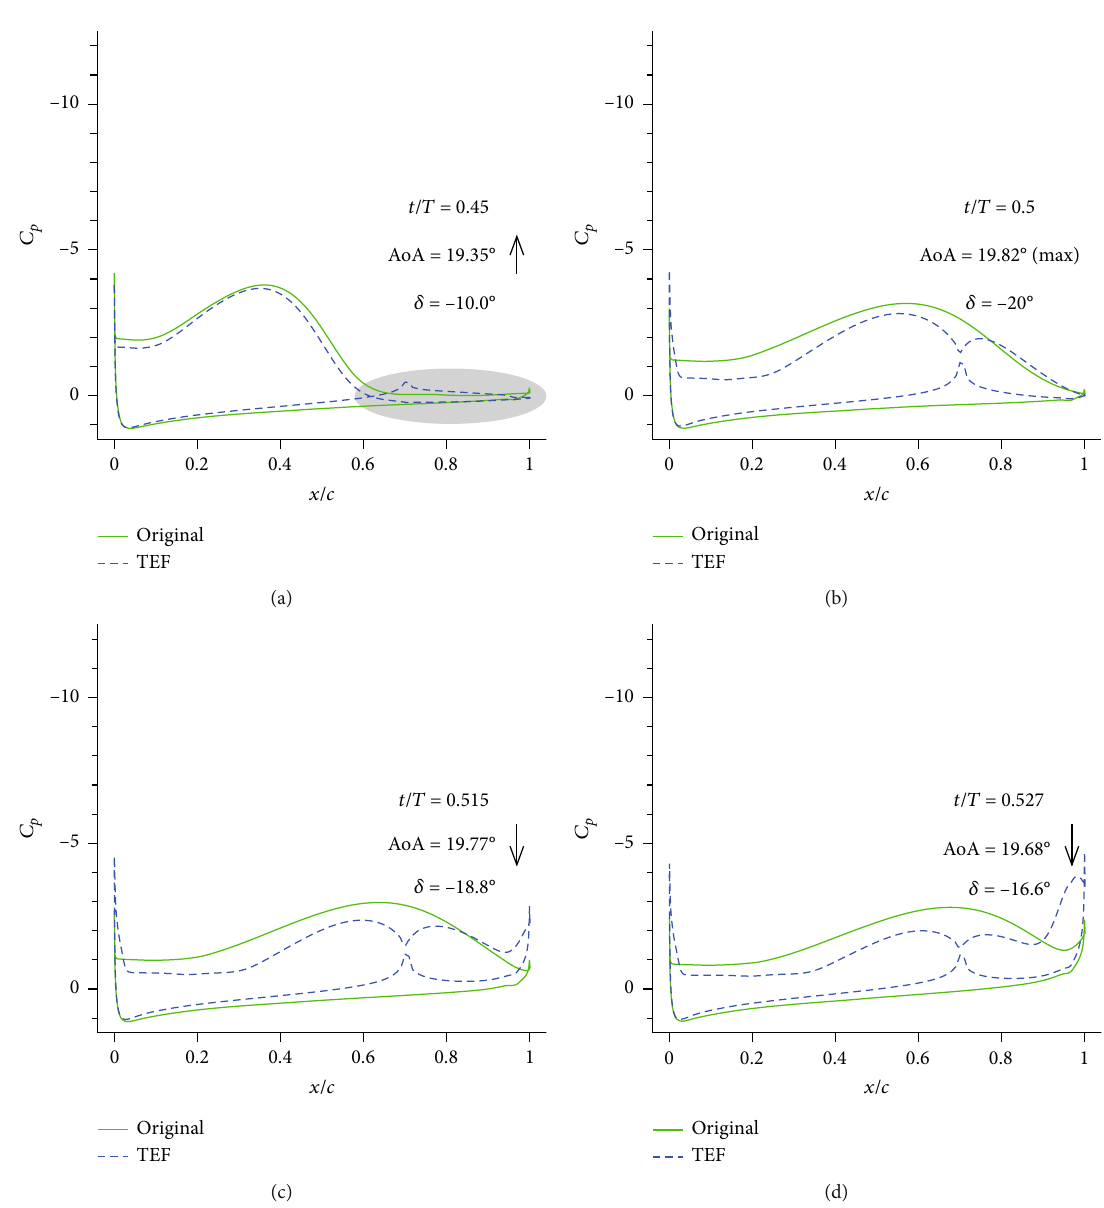
Figure 16: Comparison of pressure coe ffi cient distributions on the airfoil surface at di ff erent angles of